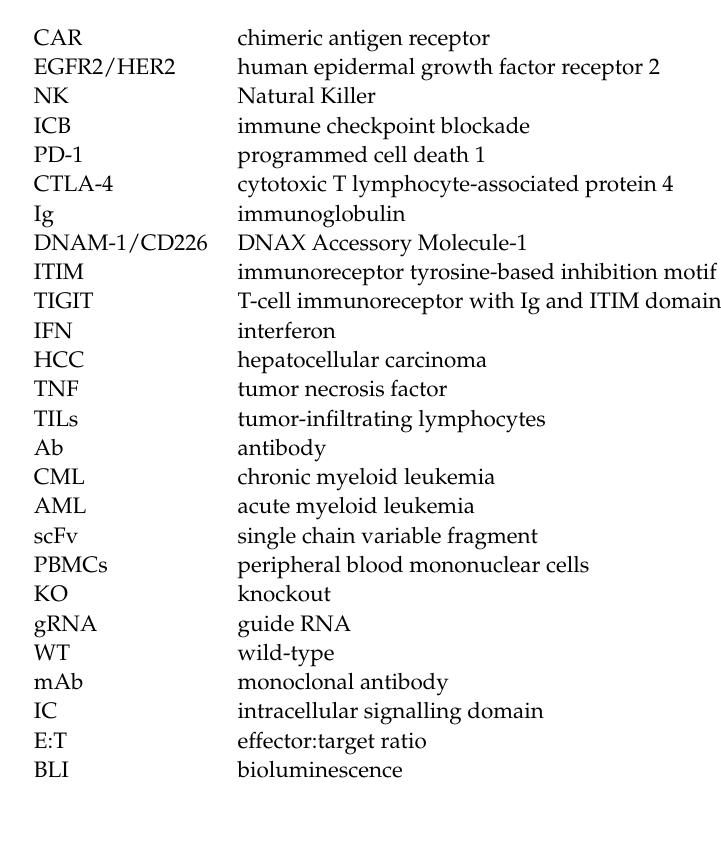
Figure S5: CD96 intracellular signalling (IC) domain plays an inhibitory role in T cell anti- tumor